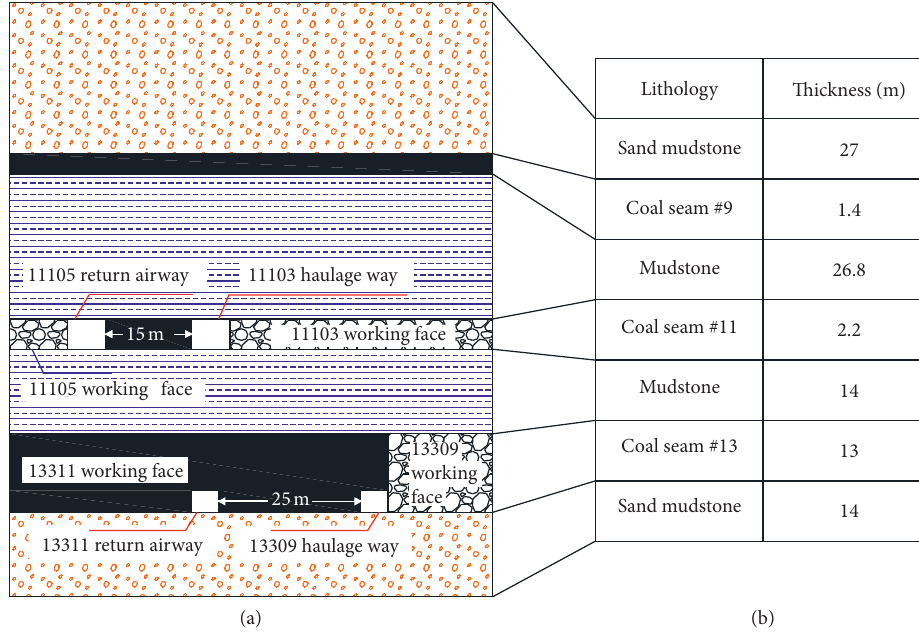
Figure 1: Comprehensive geological histogram and spatial position of the roadway.